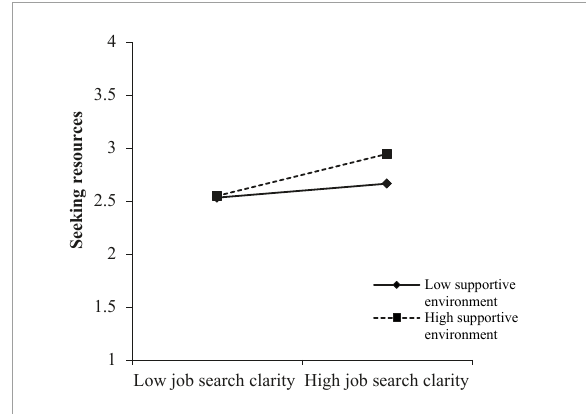
FIGURE2 Moderation effect of supportive environment on the relationship between JSC and SR.